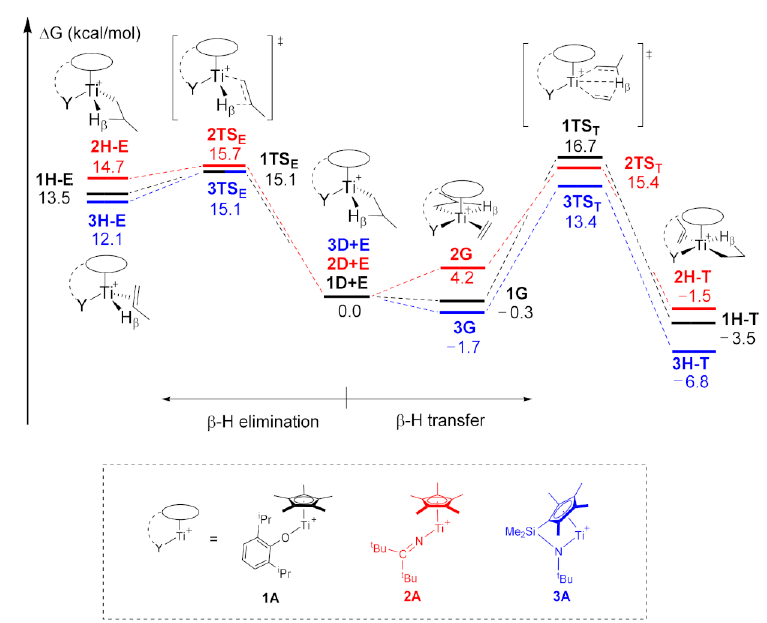
Figure 10. The calculated free energy profiles (energy in kcal/mol) for β -H elimination and β -H transfer in the termination stage of ethylene polymerization catalyzed by